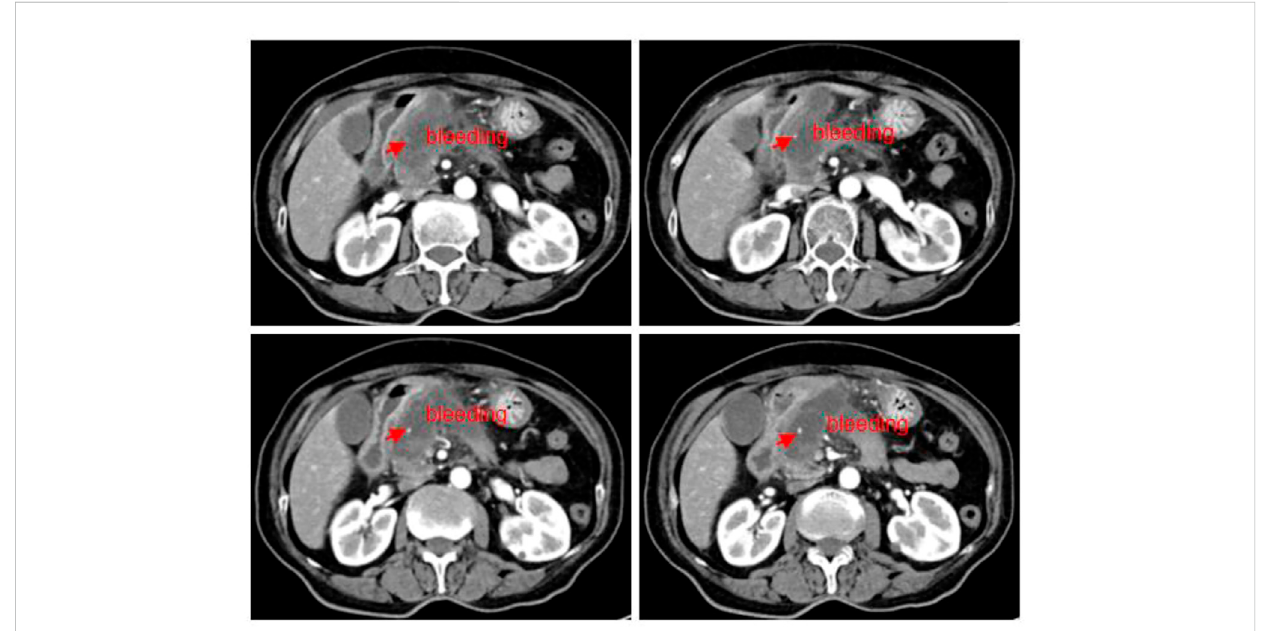
FIGURE 2 Abdominal CT scan (2022.08.27): a mass of shadow in the neck of the pancreatic head, approximately 57*32 mm; tumor with cystic necrosis was considered as a small amount of local bleeding.